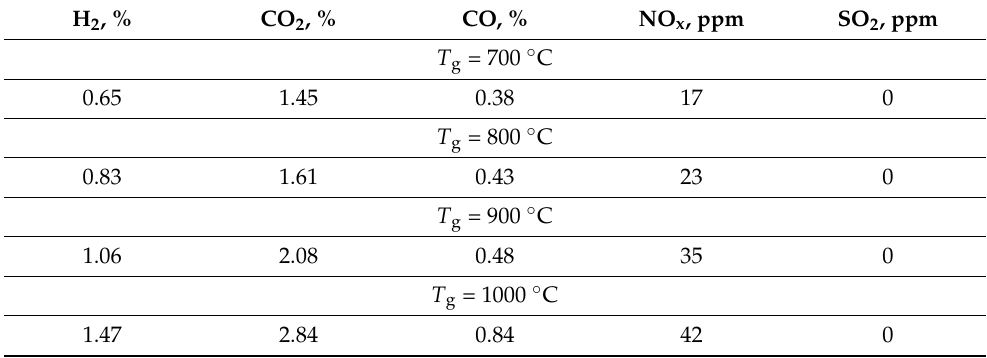
Table 2. Average gas concentrations released from the combustion of methane–propane gas hydrates ( T g is the gas temperature in the combustion chamber). H 2 , % CO 2 , % CO, % NO x , ppm SO 2 , ppm T g = 700 ◦